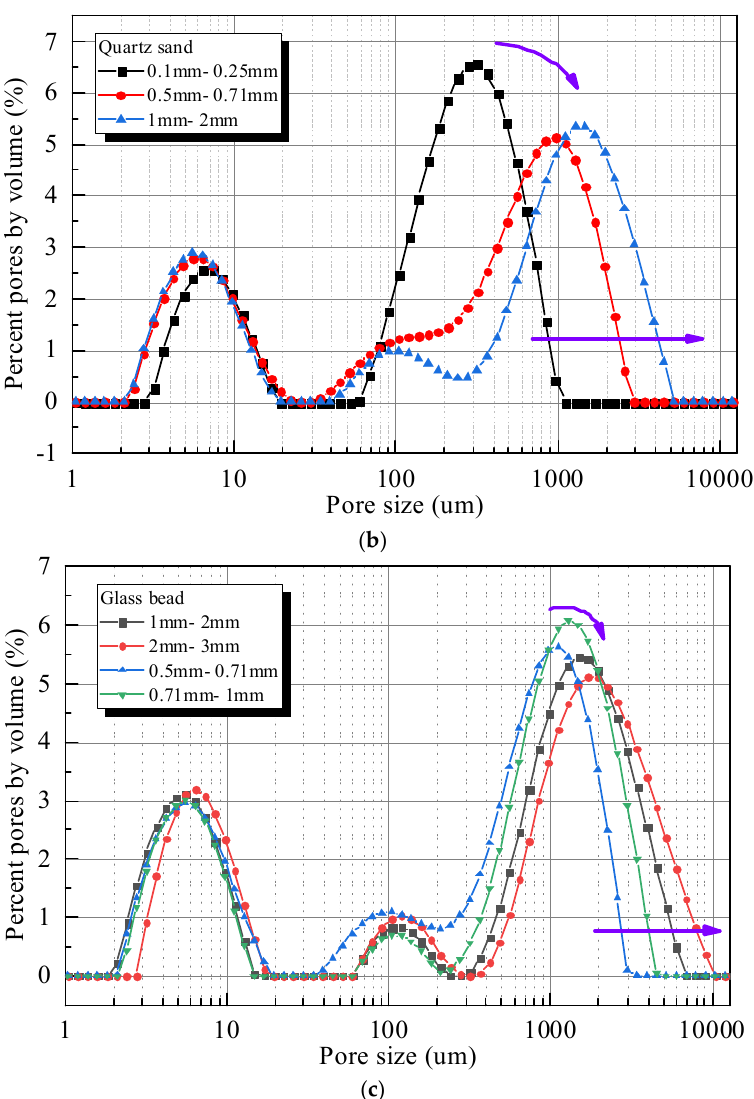
Figure 6. Pore size distribution of the tested materials with different grain sizes: ( a ) Calcareous sand; ( b ) Quartz sand; ( c ) Glass bead.